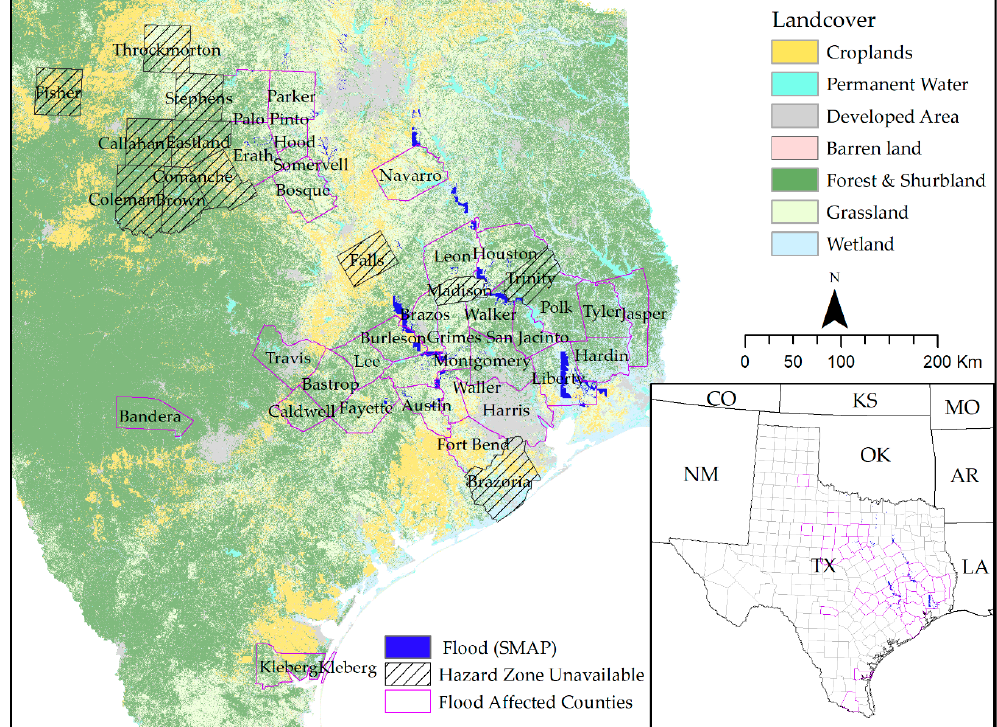
Figure 12. Inundation map extracted from SMAP of the Texas Flood (May 2016) superimposed over CDL.